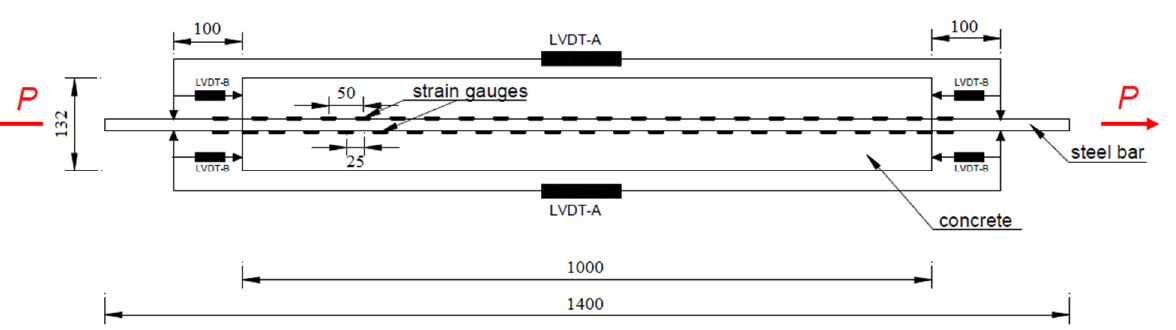
Figure 4. Insertion of electrical strain gauges in the ribbed steel rebar (unit: mm).